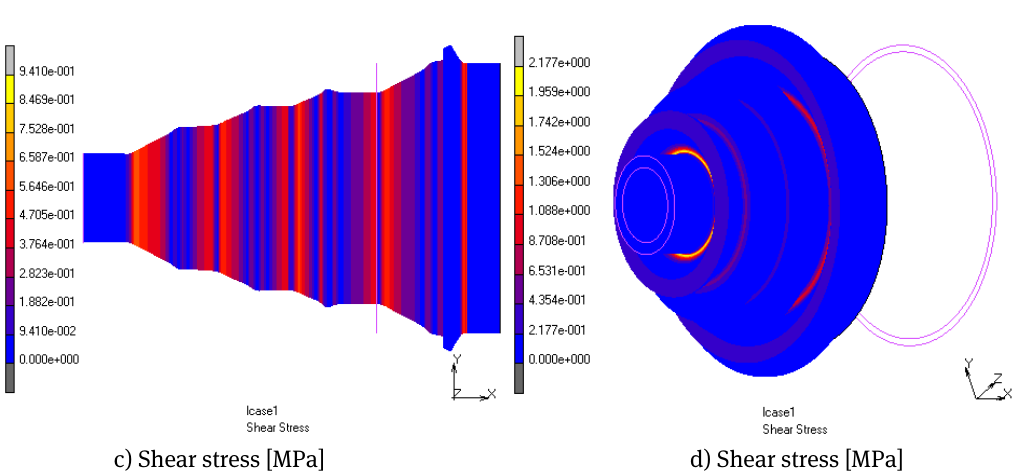
Figure 3: Images of stress and deformation of the rubber boot: a) for tension in the X, b) for compression in the X, c) the shear stress at tension, d) the shear stress at compression, e) the Cauchy stress at tension f) the Cauchy stress at compression, g) the displacement in the Y axis for rotational motion at max. speed, h) the Cauchy stress in rotation at max. speed, i) the stress in rotation at max.